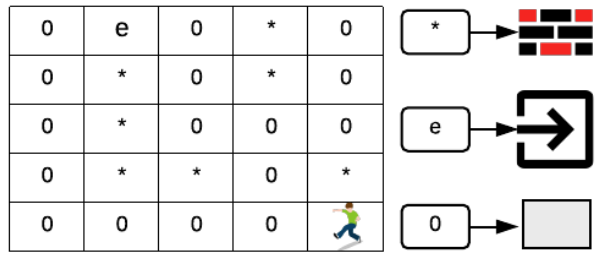
Figure 4. A symbolic representation of one floor inside the building.